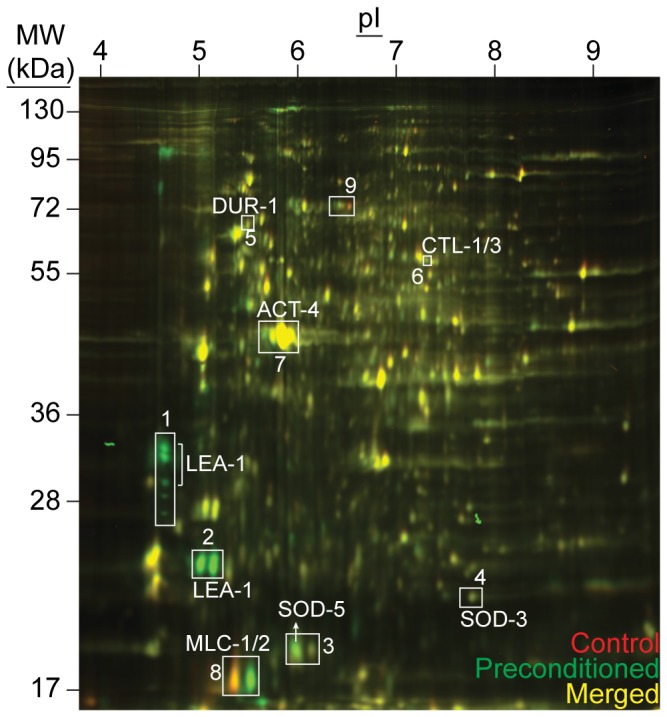
Comparison of proteomes upon desiccation.Overlay of false-colored 2D-DIGE images comparing dauer proteomes before (red) and after (green) preconditioning at 98% RH for 4 days. Yellow spots indicate proteins that do not change distinctively. The major proteins identified in these spots are annotated. The numbered regions are shown in higher magnification in Figures S2C–E. For MLC-1/2 (region 8), the red and green spots were identified as phosphorylated and dephosphorylated proteins, respectively. Region 9 possibly shows another post-translational modification.